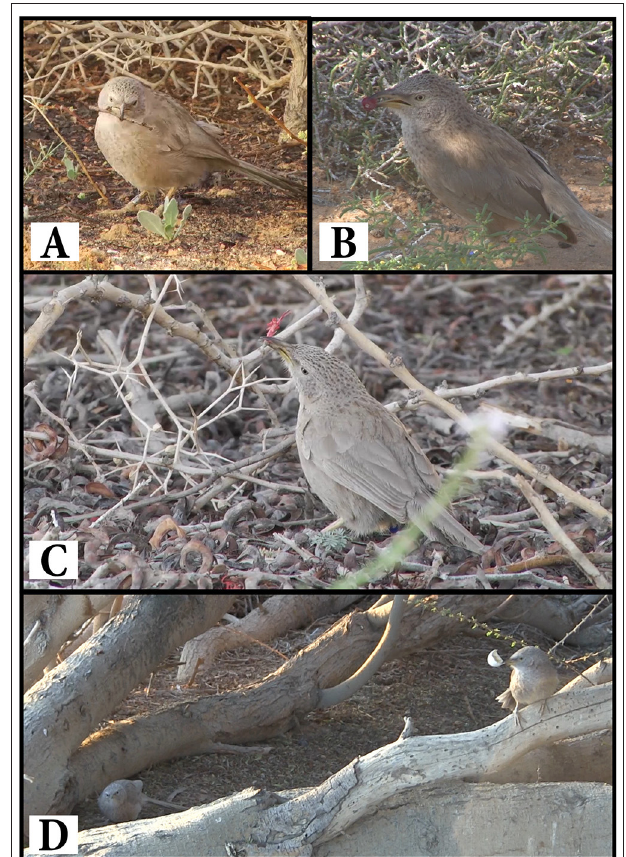
FIGURE 1 | Object presentations of (A) a twig; (B) a Nitraria retusa fruit; (C) an Acacia raddiana leaf (next to the bird’s left leg) that was dropped to the ground and replaced by a Loranthus acacia flower; and (D) an